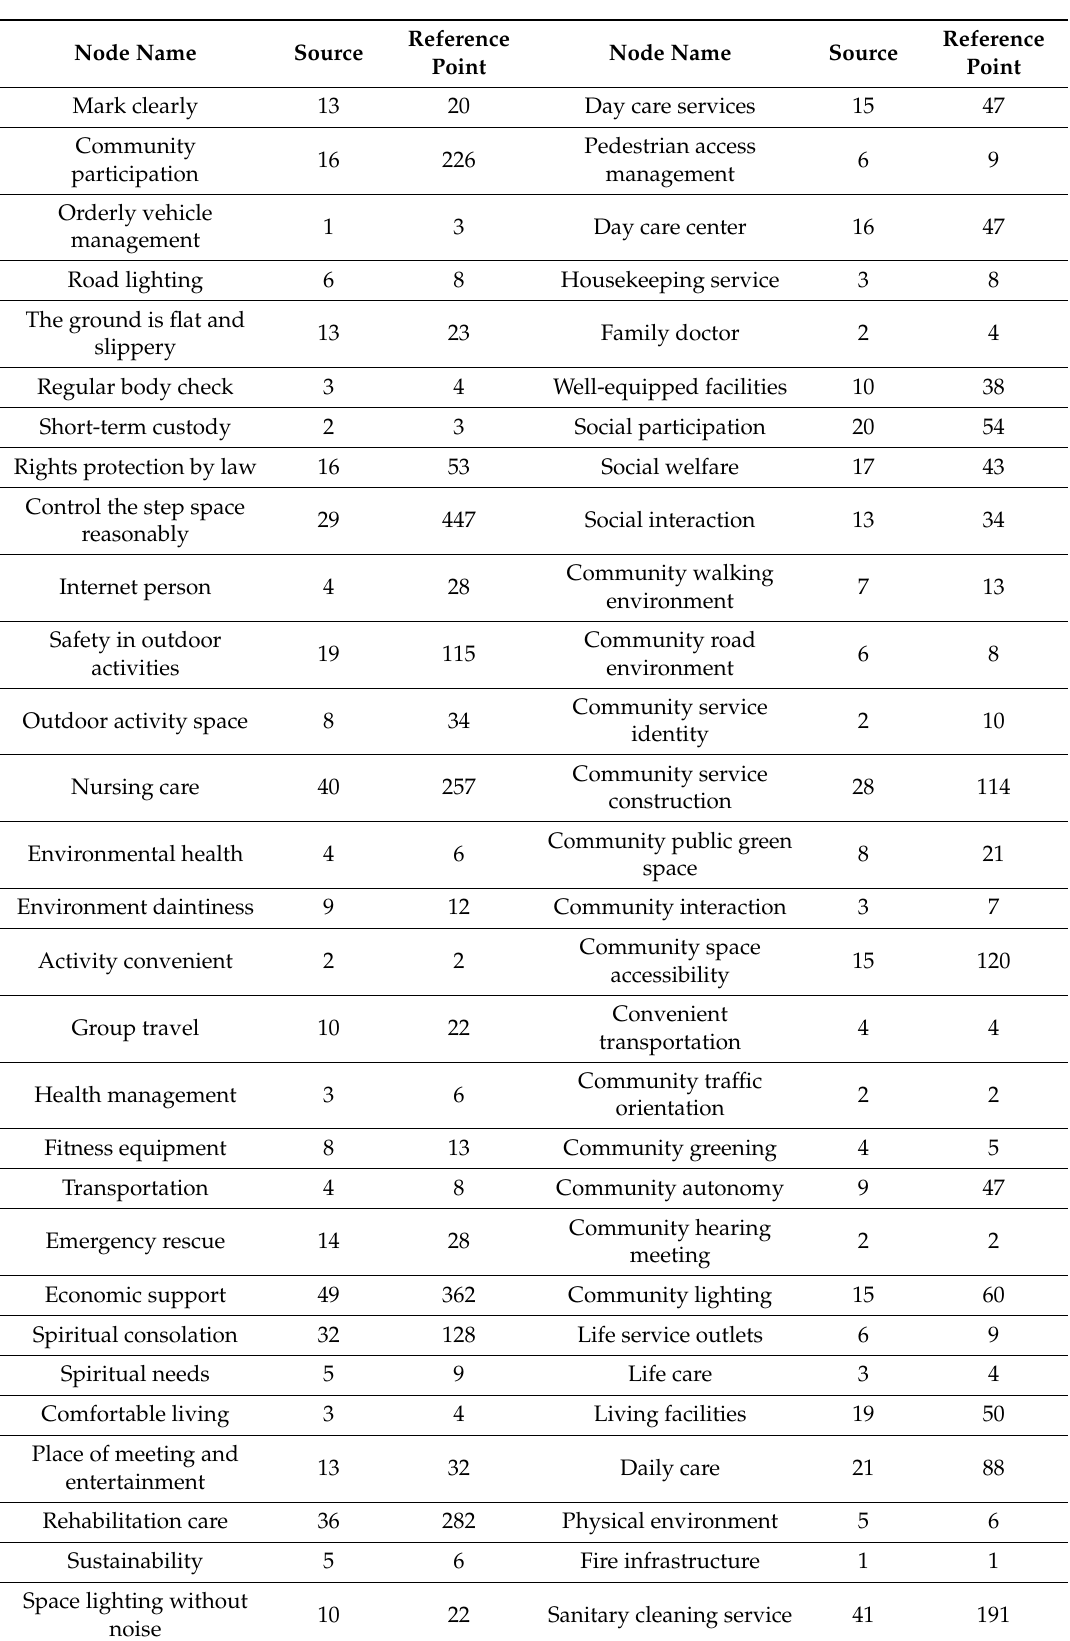
Table 2. Free node information of literature